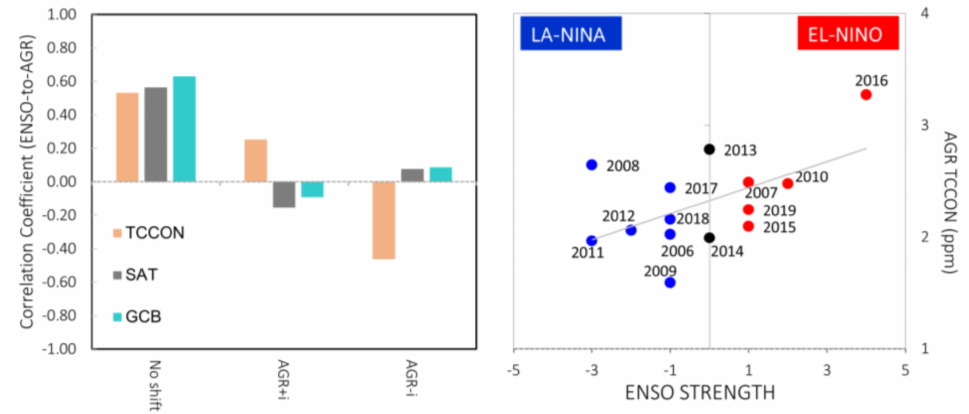
Figure 7. Analysis of AGR (TCCON, GCB and SAT) versus ENSO strength. Left panel: correlation coefficient between AGRs and ENSO for TCCON (orange), SAT (black), and GCB (green). Right panel: scatterplot between AGR TCCON and ENSO. Red color denotes El Niño conditions, blue color denotes La Niña conditions, and black denotes neutral condition. We analyzed not only ENSO vs. AGR pairs but also performed ENSO-shift analysis. More specifically, “no shift” stands for comparison between AGR i and ENSO i where i is year of analysis (AGR+i stands for a positive shift of year in relation to ENSO and AGR-i for a negative